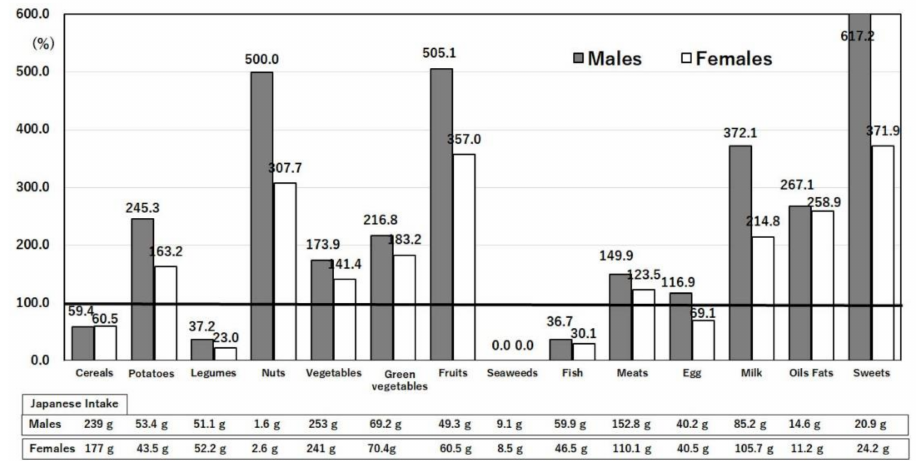
Figure 9. Ratios of food-group intakes in the U.S. compared with Japan. Values are g/day/person in the age range of 40–49 years. The intake of each item in Japan was taken as 100% [14]. The actual values of Japanese intakes obtained from the National Health and Nutrition Survey Japan, 2019, are shown below each bar. United States Department of Agriculture, NHANES 2017–2018, individuals 2 years and over (excluding breast-fed children). www.ars.usda.gov/nea/bhnrc/fsrg